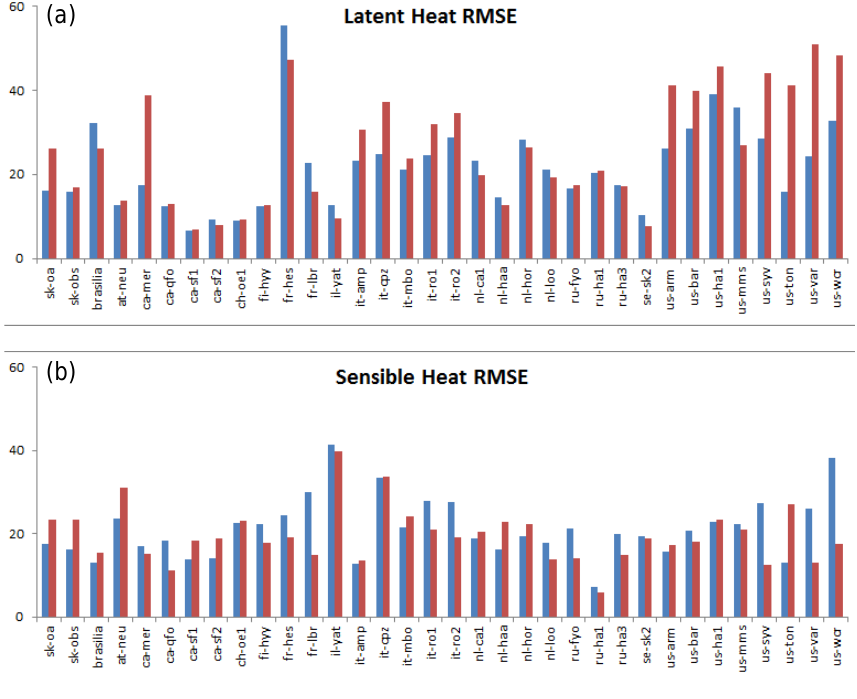
Figure 6. Root mean square error (Wm − 2 ) based on hourly values in 2004 for (a) latent heat flux and (b) sensible heat flux with respect to observations at 34 sites (as in Table 1) for ERA-Interim/Land (blue) and ERA-Interim (red).